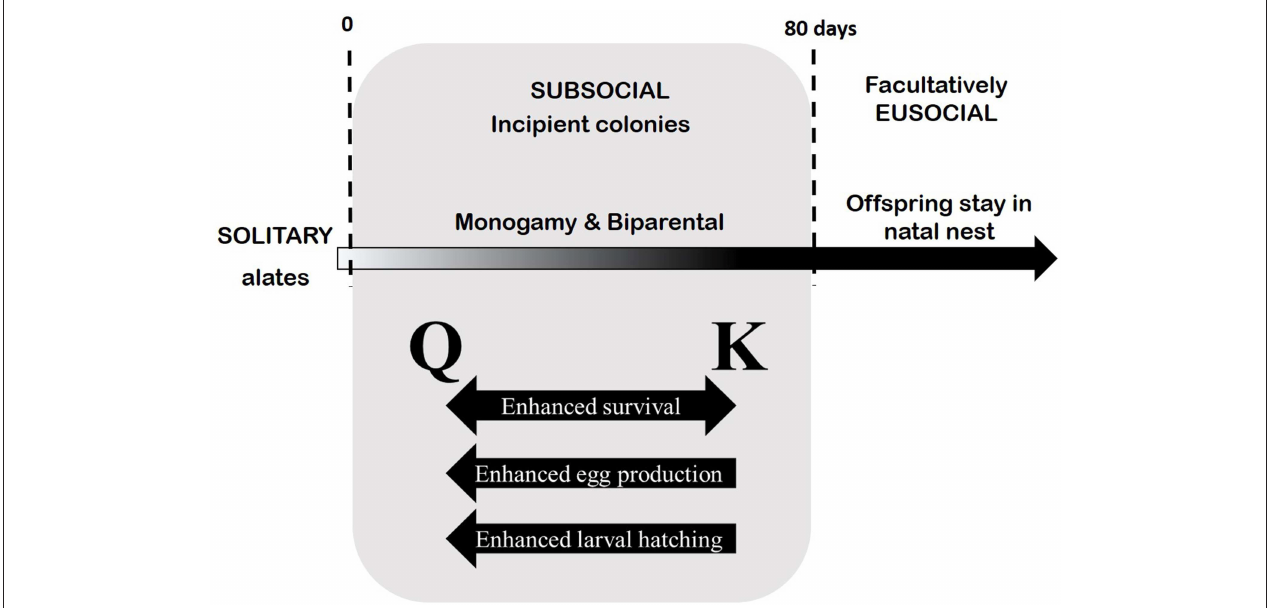
FIGURE 6 | Ontogeny of present-day Z. angusticollis colonies informed by our current data. Gray box summarizes the results of our experiment manipulations, which inform our understanding of the dynamics between the queens and kings during the subsocial phase of colony life ( ∼ first 80 days post-establishment). Specifically, the continued presence of the king and/or his stored resources (i.e., mass) result in enhanced fitness, as measured by queen survival, egg production and larval hatching